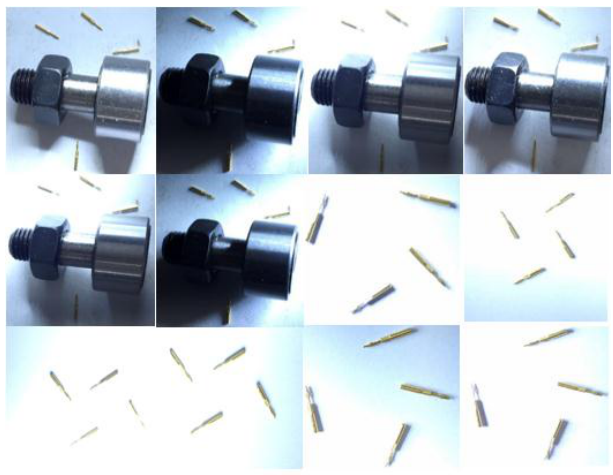
Figure 11. Sample images of multiple categories of mechanical parts with complex illumination and background.